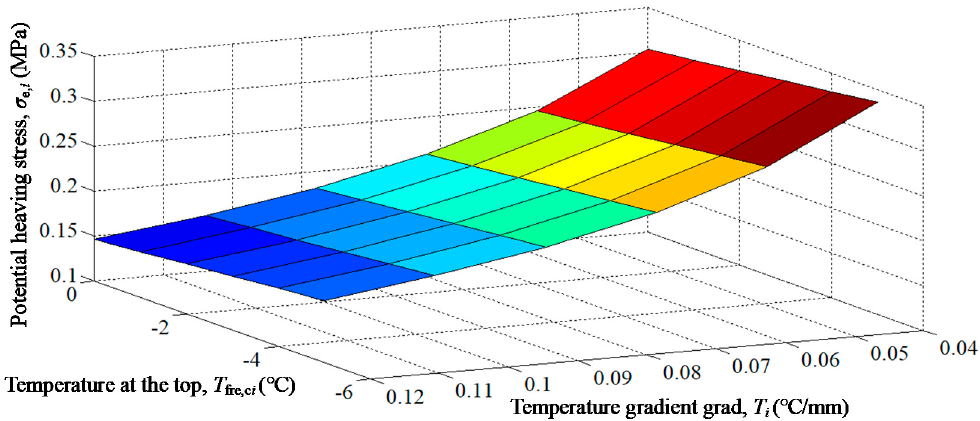
Figure 15. Potential frost heaving stress vs. temperature gradient and temperature at the top of the i th freezing soil